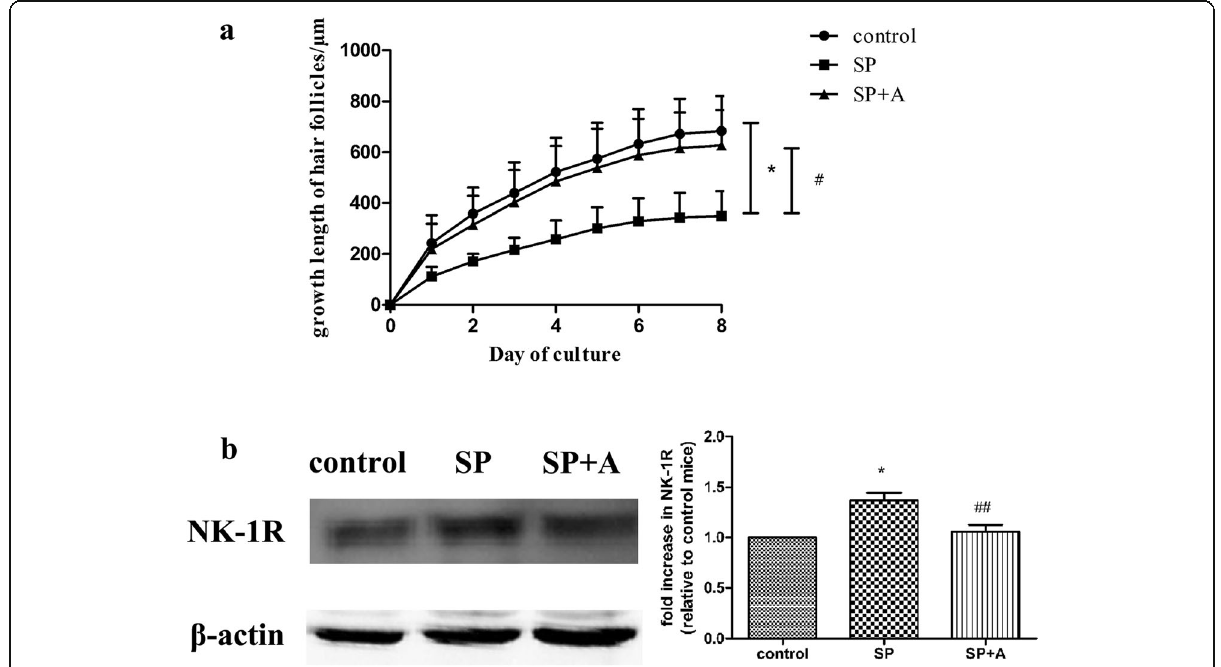
Fig. 5 Effects of AVE on peptidergic innervation in murine dorsal skin. Histochemical detection reveals the location and expressions of SP + and CGRP + nerve fibers (red staining, pointed out by arrows) by immunofluorescence ( a ), and the number of SP + and CGRP + nerve fibers per visual field in the skin from four mice groups were measured ( b ). In the immunofluorescence micrographs, nerve fibers are labeled in red, and cell nuclei are labeled blue with DAPI. The number of nerve fibers was quantified at least 10 visual fields per mouse, 3 – 5 mice each group. Results shown are mean ± S.E.M. *** p < 0.001 compared with control; ### p < 0.001 compared with RS group. Abbreviations: e, epidermis; d, dermis; hf, hair follicle. Magnification: 200